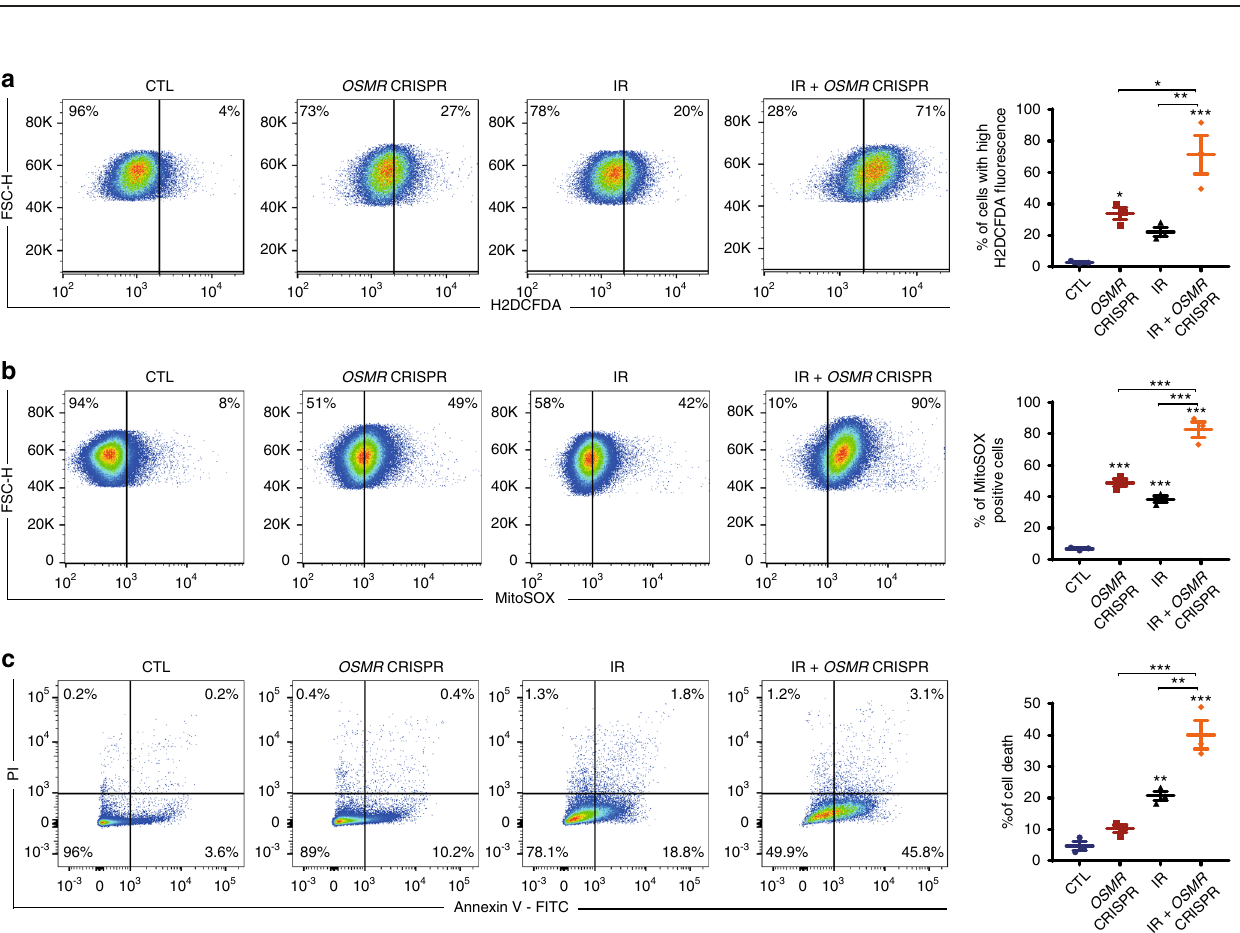
Fig. 6 OSMR CRISPR induces ROS generation and promotes apoptosis in response to IR. a – c OSMR CRISPR and control BTSC73 were subjected to